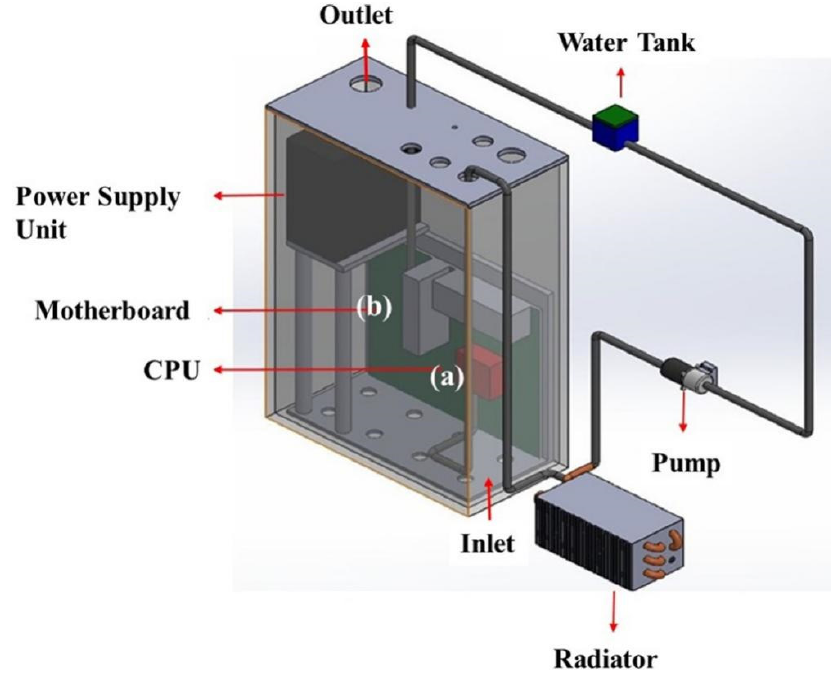
Figure 13. The schematic diagram of single-phase [67].